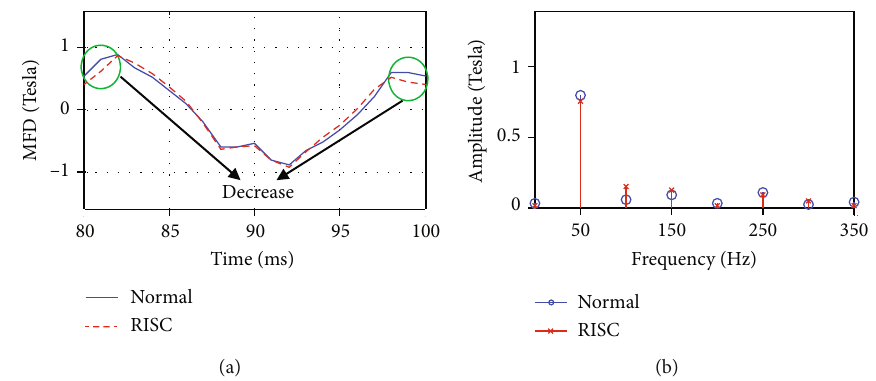
Figure 5: Radial fl ux density of the QFSN-600-2YHG generator: (a) time wave and (b) spectrum.